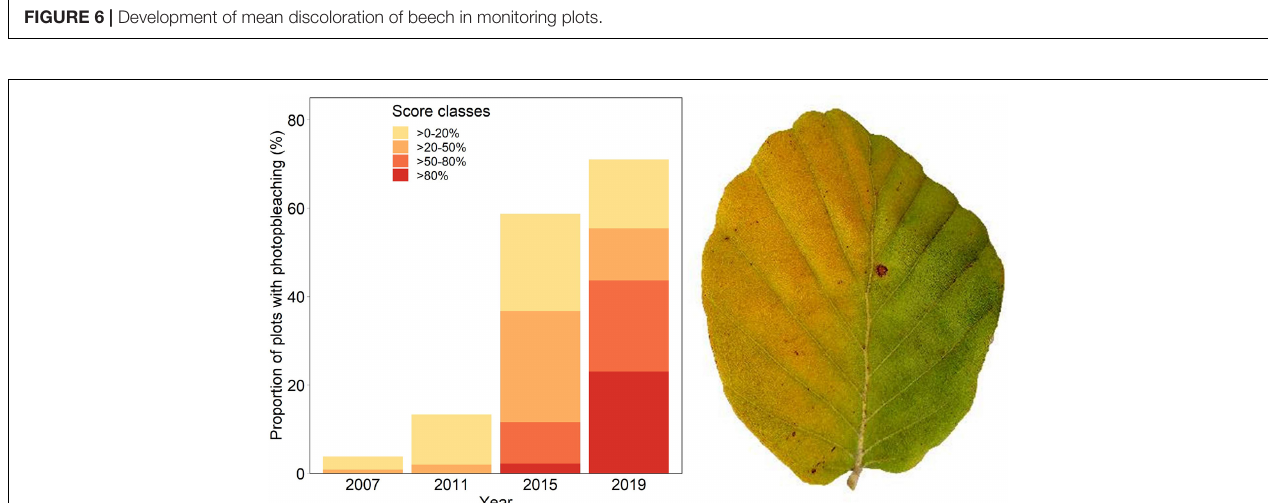
FIGURE 6 | Development of mean discoloration of beech in monitoring plots.